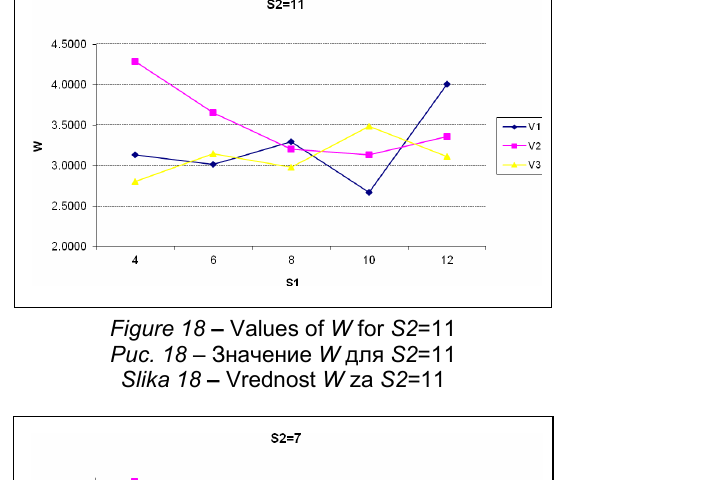
Figure 18 – Values of W for S2 =11 Рис . 18 – Значение W для S2 =11